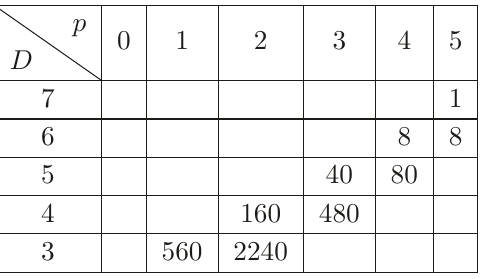
d 3 (cid:1) (cid:0)